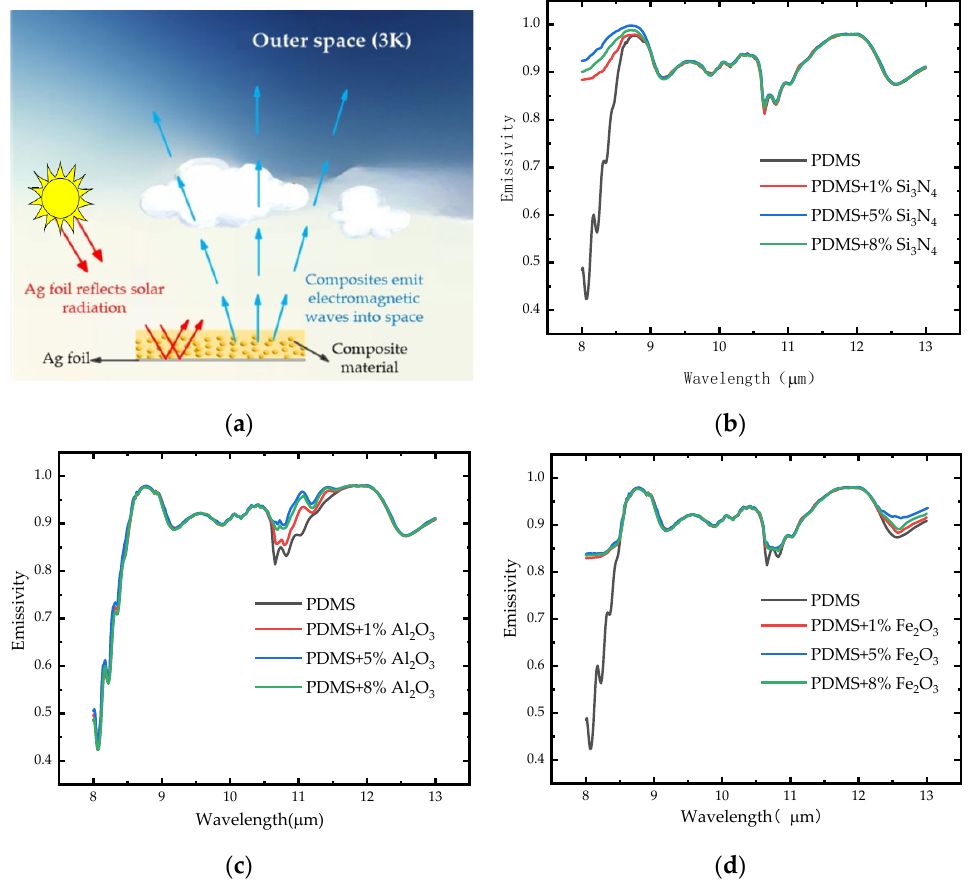
Figure 6. Emissivity of PDMS after adding particles with different volume fractions: ( a ) Schematic diagram of radiant cooling process of composite materials; ( b ) emissivity of PDMS materials mixed with different volume fractions of Si 3 N 4 ; ( c ) emissivity of PDMS materials mixed with different volume fractions of Al 2 O 3 ; ( d ) emissivity of PDMS materials mixed with different volume fractions of Fe 2 O 3 .